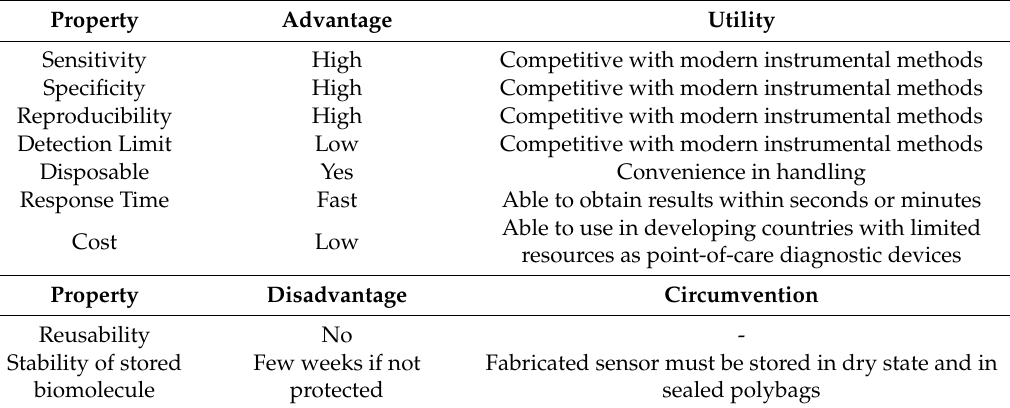
Table 4. Advantages and disadvantages of paper-based biosensors over ELISA-based sensing